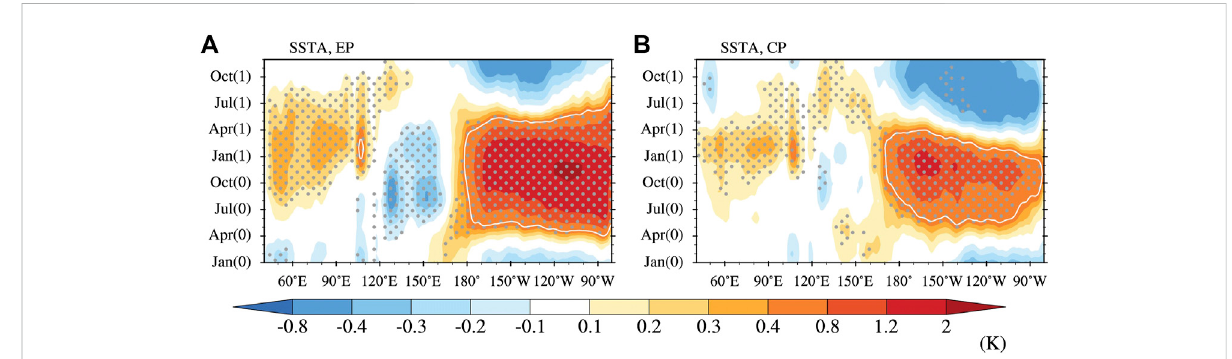
FIGURE 1 Time – longitude cross-section of the composite sea surfacetemperature anomaly (SSTA; units: K) at the equator (averaged from 5 ° S to 5 ° N) for (A) EP El Niño events and (B) CP El Niño events, where (0) indicates the El Niño developing year and (1) represents the decaying year. White contours indicate regions with a SSTA greater than +0.5 K and gray dots denote a SSTA statistically signi fi cant at the 90% con fi dence